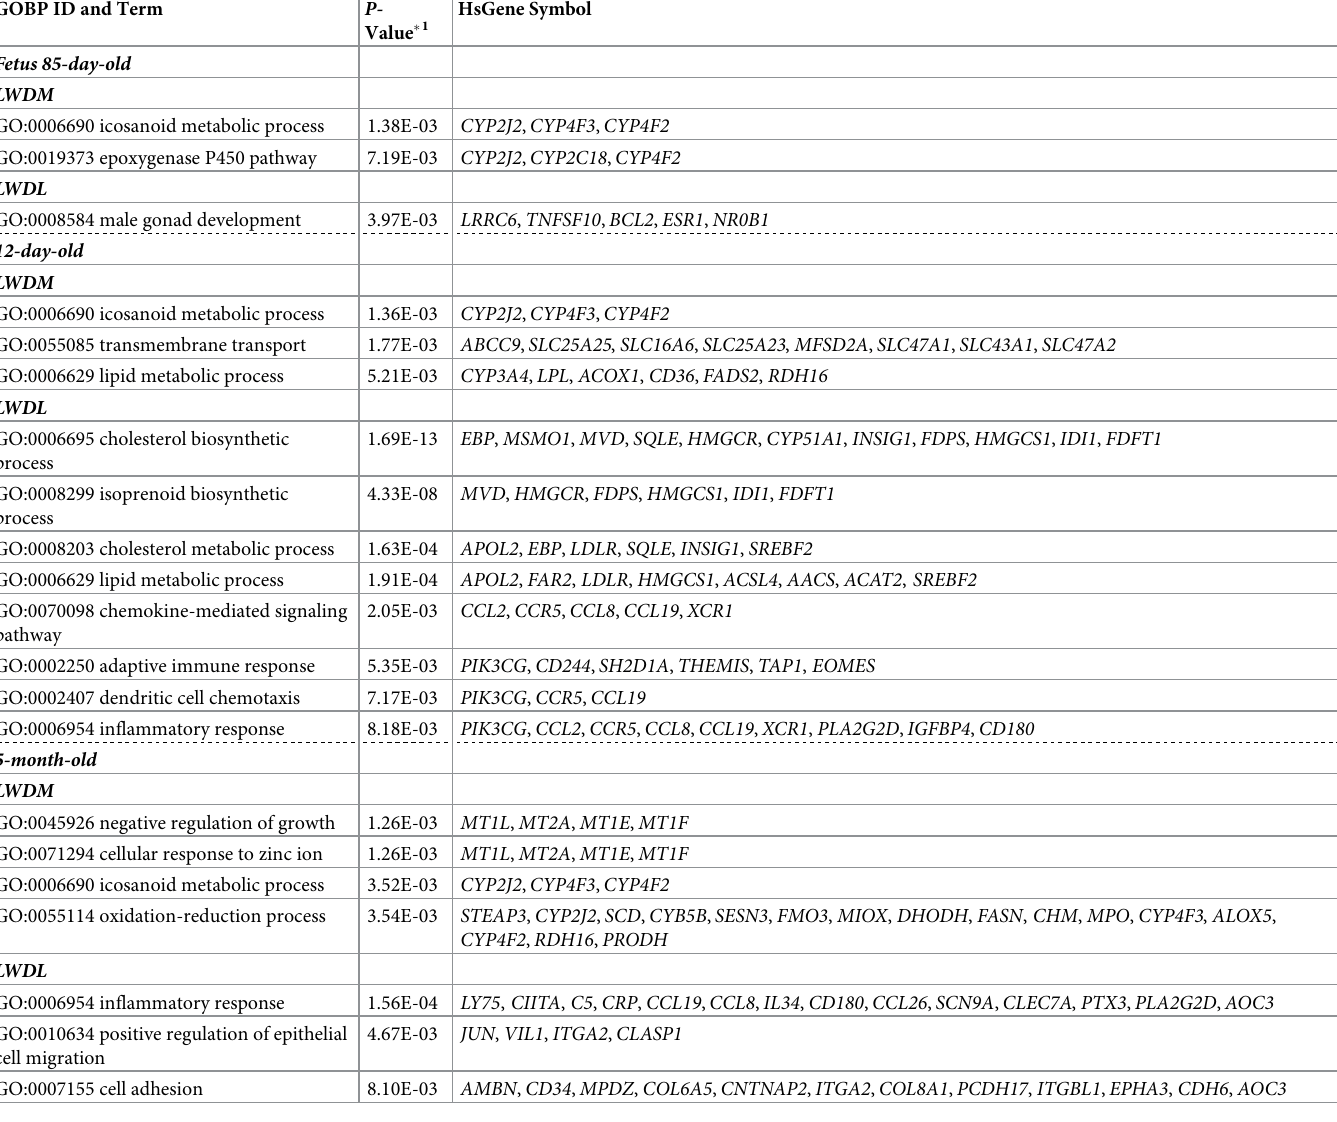
Table 5. Annotation profile of the genes with > 2.0-fold predominant expression in the liver tissue of LWDM and LWDL